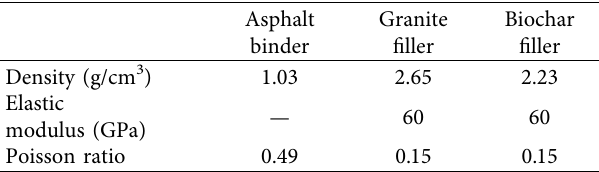
Table 1: Material